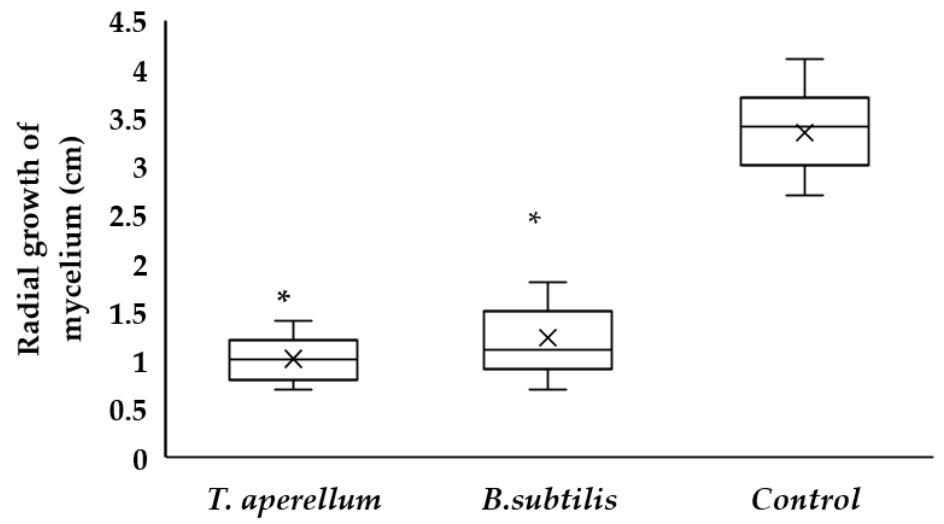
Figure 1. Radial growth of mycelium of T. asperellum, B. subtilis , and Control ( Rhizoctonia sp.). * Indicates that there were significant differences between the two microorganism and Control group ( p < 0.01; Dunnett’s test).